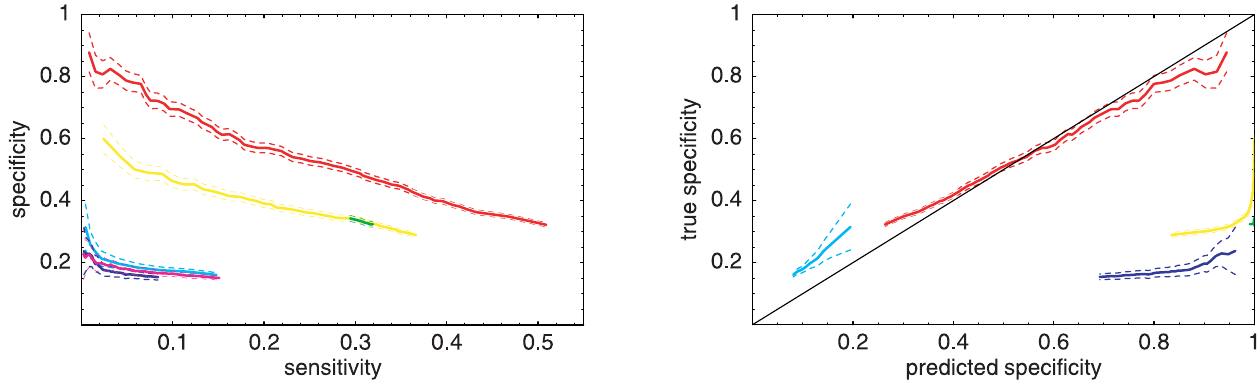
Figure 5. Performance of Several Motif-Finding Algorithms on Synthetic Data Prepared as for Figure 3 A total of 250 alignments of S ¼ 5 orthologous intergenic regions of length L ¼ 750 and proximity q ¼ 0.5 were created with three binding sites sampled from each of three different random WMs. The left panel shows how the fraction of predicted sites that match true sites (specificity) depends on the fraction of true sites that are among the predictions (sensitivity) for PhyloGibbs (red), EMnEM (yellow), PhyME (green), PhyloGibbs without phylogeny (light blue), WGibbs (dark blue), and MEME (pink). Dashed lines correspond to two standard errors. The right panel shows the ability of the different algorithms to assess their own reliability. The true specificity is shown as a function of the specificity that the algorithm predicts for the sites that it reports. The black line y ¼ x corresponds to a perfect assessment of the algorithm’s reliability. DOI: 10.1371/journal.pcbi.0010067.g005